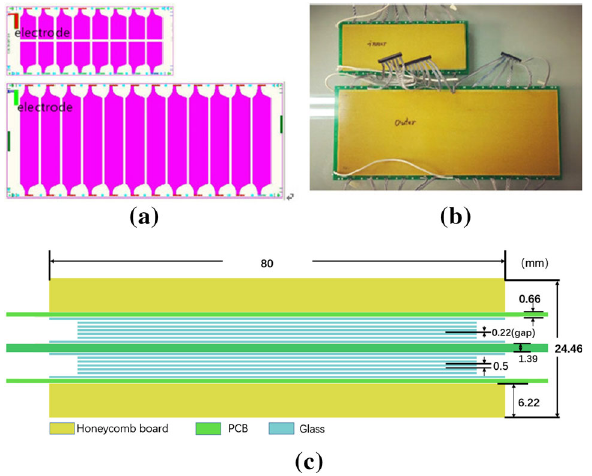
Fig. 4 MRPC module design and prototypes. The readout pad design for the inner layer is shown in the upper image ( a ) at the top left, and the design for outer layer of the MRPC is shown in the lower image ( a ) at the top left. A photograph of the finished MRPC prototypes is shown at the top right ( b ). The side view of the MRPC is shown in the bottom panel ( c )